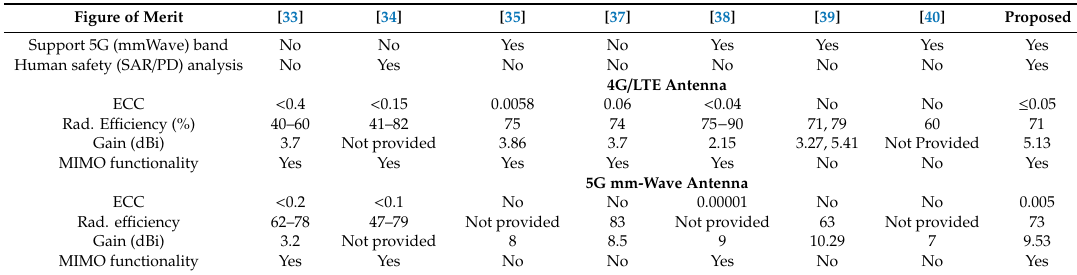
Table 5. Comparison with the Literature